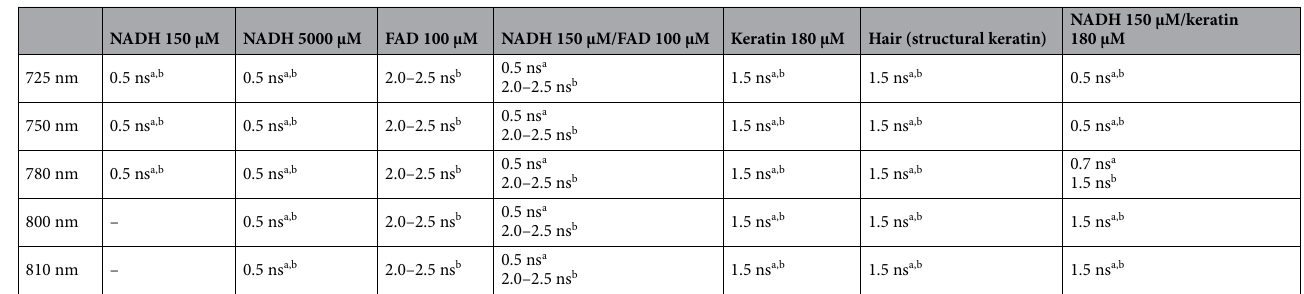
Table 2. Fluorescence lifetime data from the measurements done on the fluorophores in solution, and hair. a 445/60 nm channel. b 580/150 nm